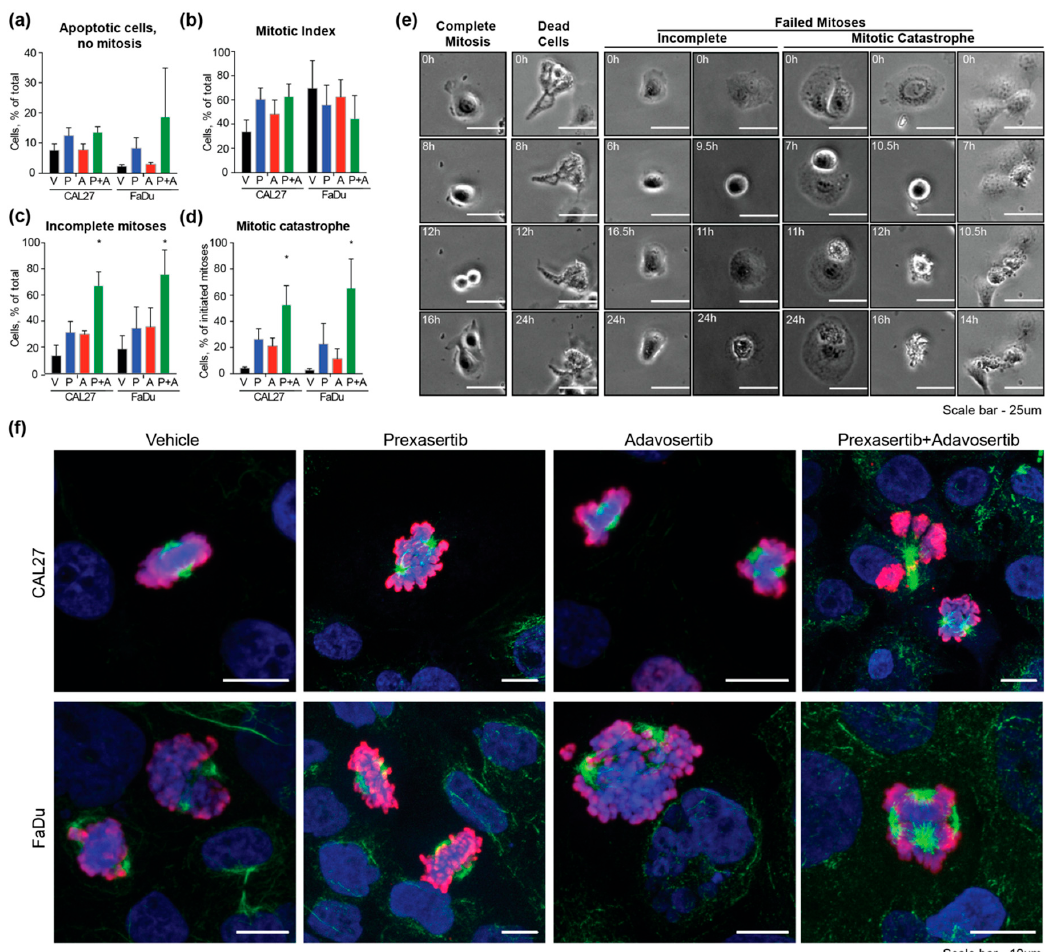
Figure 5. Combination of prexasertib and adavosertib causes mitotic catastrophe. ( a–d ) Quantification of percent of CAL27 and FaDu cells ( a ) undergoing apoptosis without prior mitosis; ( b ) entering into mitosis; ( c ) unable to successfully complete mitosis; ( d ) undergoing apoptosis after initially entering mitosis over 24 h of live cell imaging following addition of indicated drugs; and ( e) representative images of CAL27 cells related to ( a–d ). Scale bar, 30 um; ( f ) confocal images of cells, stained with DAPI to visualize nuclei (blue), and antibody to acetylated α -tubulin to visualize mitotic spindle (green), or to phospho-histone H3 to visualize DNA breaks (red), 24 h after treatment with indicated drugs. Scale bar, 10 um. All graphs: *, p ≤ 0.05; relative to vehicle controls.